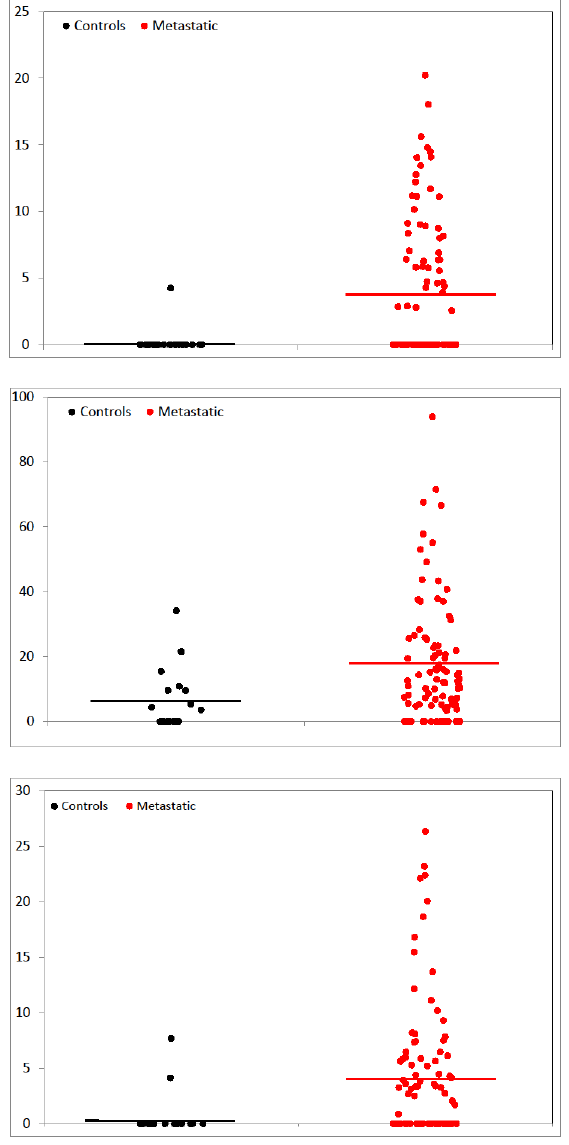
Figure 3. Dot plots representing abundance values for controls and metastatic patients. From top to bottom, plots refer to signals m / z 1561.72, 2021.08 and 2399.17. Dots on the left (black) represent controls, dots on the right (red) metastatic patients. The horizontal lines show the average values. Dots are randomly spread along the abscise axis for visibility. Scales are adapted to values.